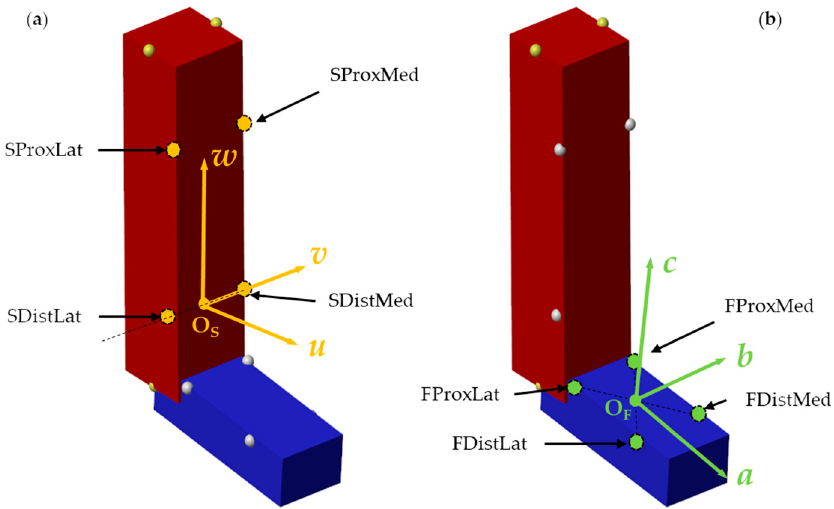
Figure 3. ( a ) Shank local coordinate system (IHA/SARA); ( b ) foot local coordinate system (SARA).